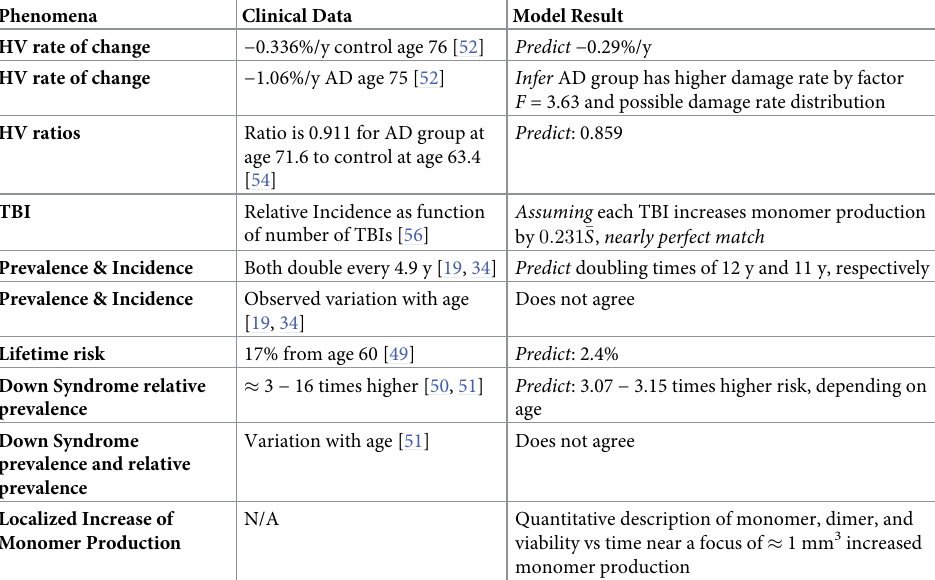
Table 3. Summary of model results. Each result is presented in this manuscript. Three significant figures are used as the model results come from formulas and the parameters were stored with 3 significant